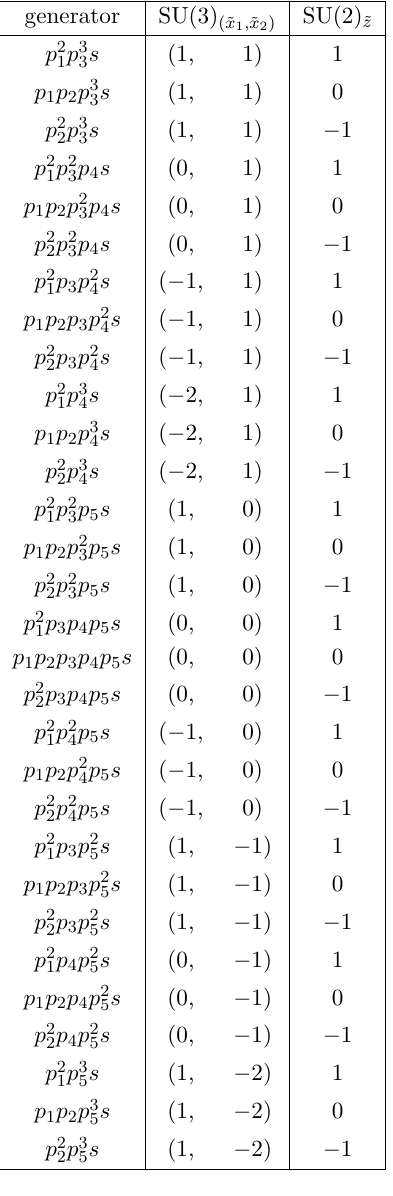
Table 10 . The generators and lattice of generators of the mesonic moduli space of Model 2 in terms of brick matchings with the corresponding flavor